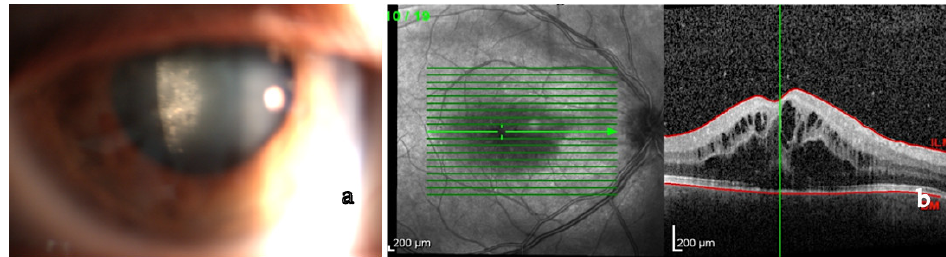
Figure 4. Ocular sarcoidosis complications: subcapsular cataract ( a ), acute CME ( b ). Sarcoid uveitis can lead to increased IOP and, consequently, glaucoma primarily due to steroid therapy, edema, debris or inflammatory cells that cause trabecular meshwork obstruction, alone or in combination. Granulomatous orbital masses can give rise to high IOP too, as a consequence of compression.